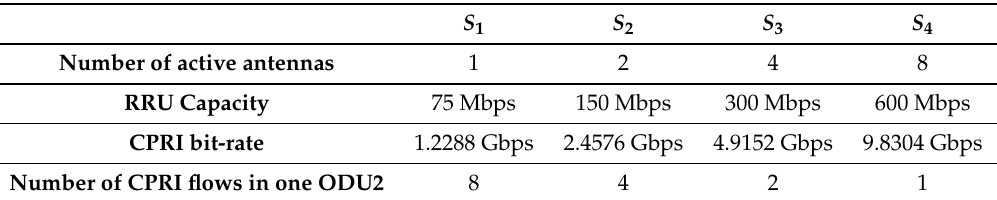
Table 3. Number of active antennas, RRU capacities, CPRI bit-rates and maximum number of CPRI flows carried in one ODU2 for the antenna configurations S 1 , S 2 , S 3 and S 4